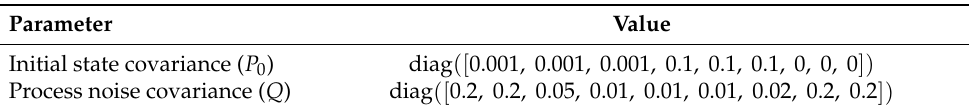
Table 7. Initial state covariance and process noise covariance matrices for the unknown landmarks scenario.